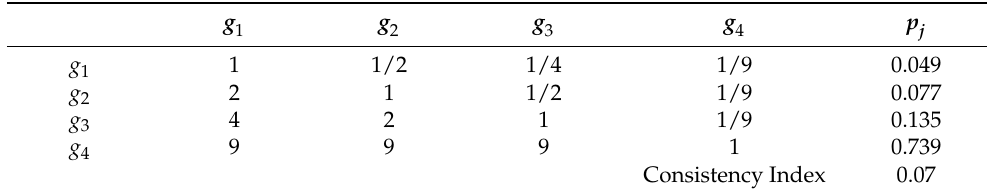
Table 2. Pairwise comparison matrix between